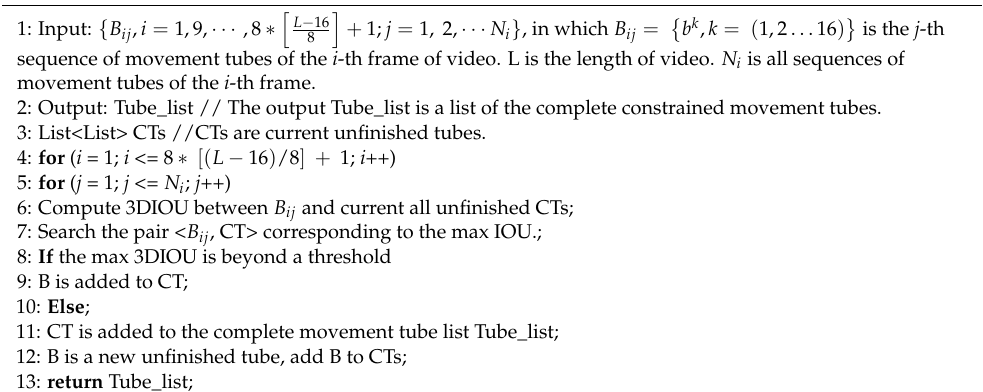
Algorithm 1. The adjacent movement tube linking